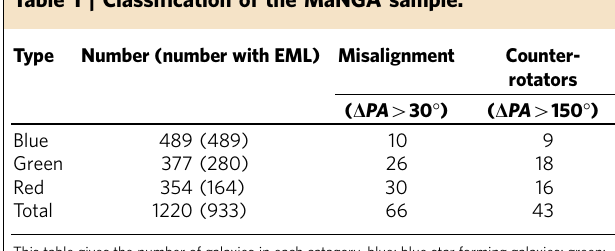
Table 1 | Classification of the MaNGA sample.